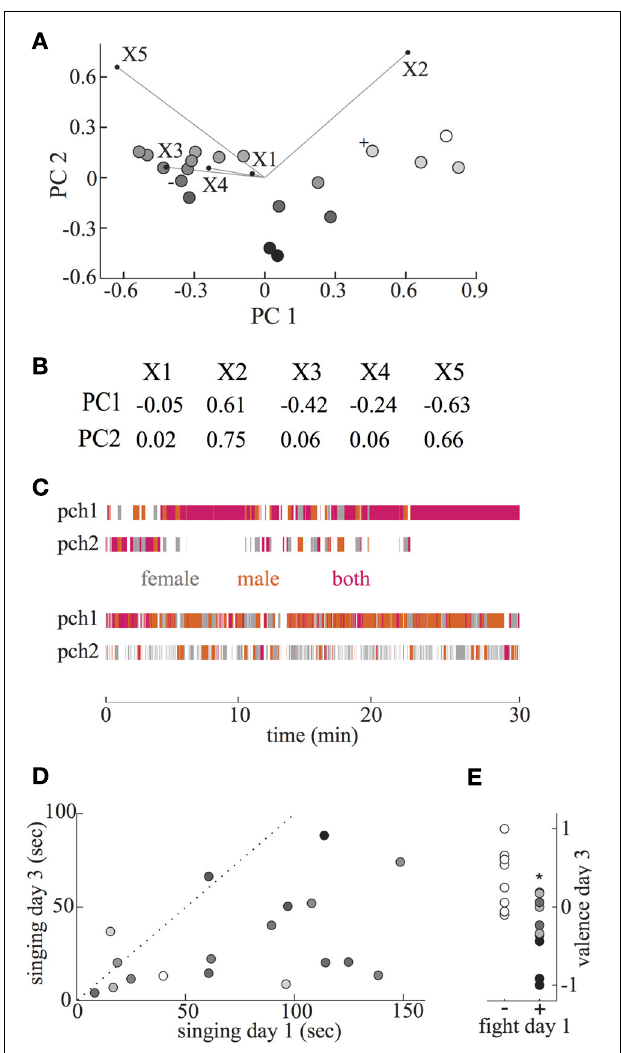
FIGURE 2 | Information from tracking system used to obtain pair valence, and relation of courtship behaviors to valence. (A) A Principal Component Analysis (PCA) was performed on five behavioral features of interactions of female and male birds. Results from the first two principal components, which accounted for 88% of the variance, are plotted for each pair. Mappings of each behavioral factor are overlaid projected within this plane, with the length of the line equal to the PC1 and PC2 components. The five behavioral features are: X1—% time spent jumping between perches, X2—% time both birds on same perch, X3—average distance between birds when both on same perch, X4—distance moved when jumping between perches, X5—% time both birds on opposite perches. Symbols for pairs which had positive and negative valences, illustrated in (B) , are labeled with “ + ” and “ − ,” respectively. The final calculated valence of each pair is coded with a grayscale map, from black = − 1 to white = + 1. B. Relationship of PC1 and PC2 to the five behavioral features used. (C) Presence of female and male birds on either perch in the cage for each video frame. Video frames when only the female or male was on perch 1 (pch1) or perch 2 (pch2) are indicated with gray and orange, respectively. Frames when both female and male were on the same perch are indicated by magenta. Upper and lower perch position plots represent data from day 3 recordings of positive valence (0.38, indicated by “ + ” to left of symbol in A ) and negative valence ( − 0.24, indicated by “ − ” to left of symbol in A